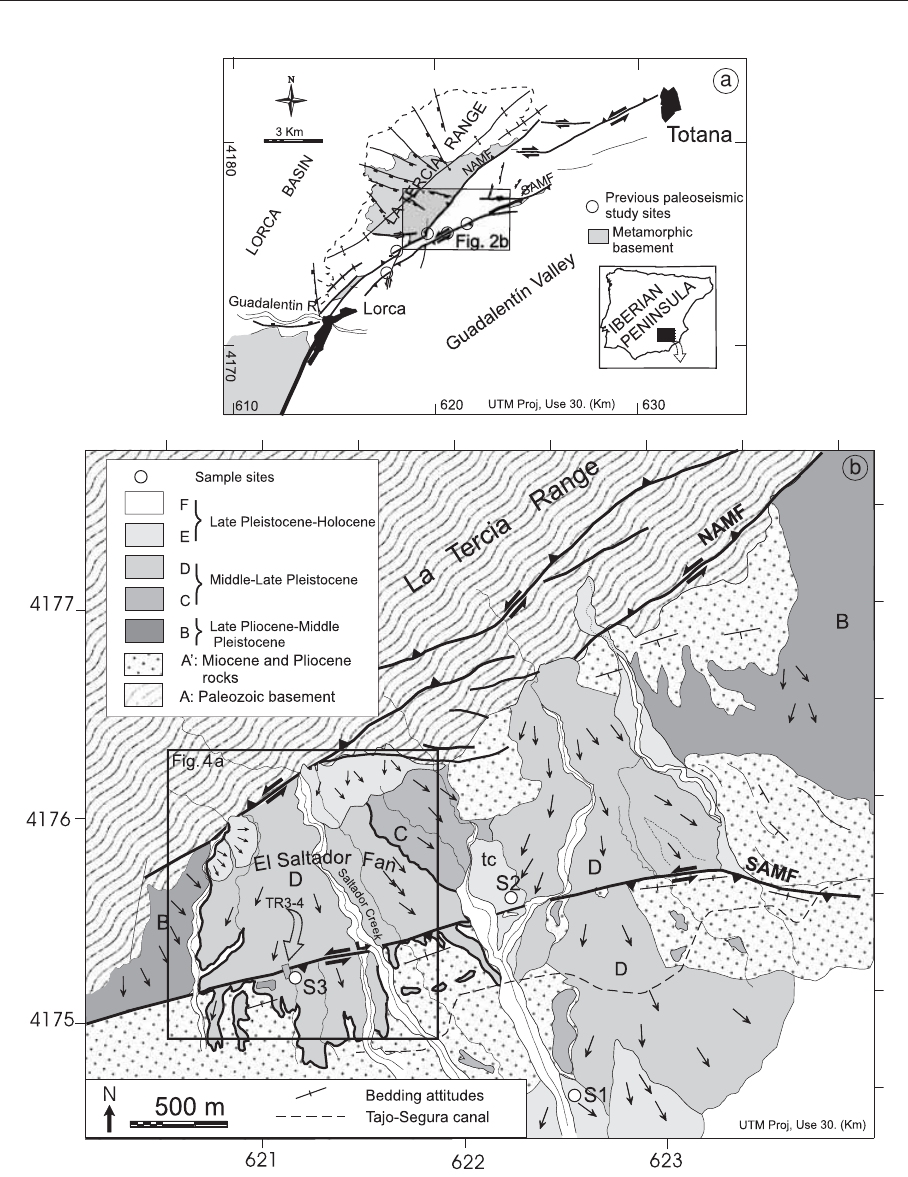
Fig. 2a,b. a) Schematic tectonic map of the Lorca-Totana section of the Alhama de Murcia Fault. This fault is a left-lateral, reverse fault composed of two NE-SW strands: the Northern Alhama de Murcia Fault (NAMF) NW-dipping, high angle reverse fault, and the Southern Alhama de Murcia Fault (SAMF) SE-dipping, high angle left-lateral, oblique-slip fault. b) Map of the Quaternary sediments in the studied area. The largest Middle-Late Pleistocene alluvial fans are related to the El Saltador and Colmenar creeks, and are cut by the SAMF and the NAMF. The small arrows represent the main drainage directions on top of the alluvial fan surface. S1-3 show the sampling sites were 13 samples from the upper layers of the alluvial fans were collected and dated (tables II and III). Tc - fluvial terrace of Colmenar.